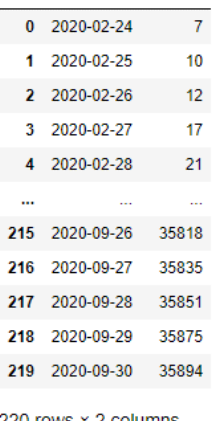
Figure 6. Civil Protection’s dataset of